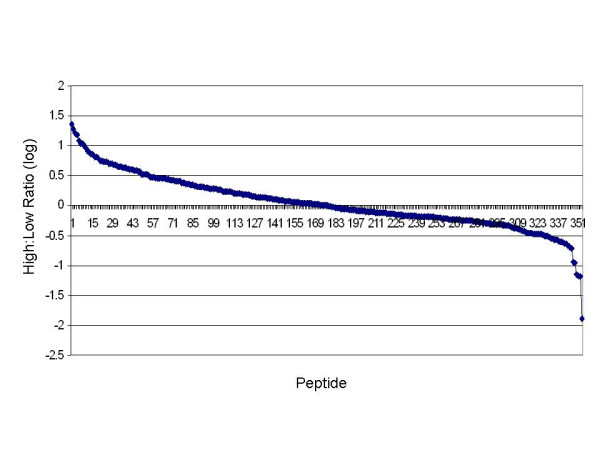
Using the ProICAT bioinformatics program, 353 peptides were identified. Approximately equal numbers of proteins were up- versus down-regulated.